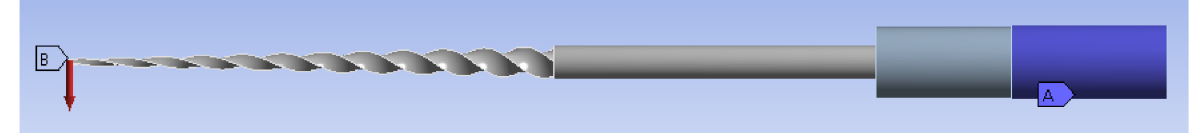
Fig. 4. Boundary conditions input in hyplex CM endodontic fi